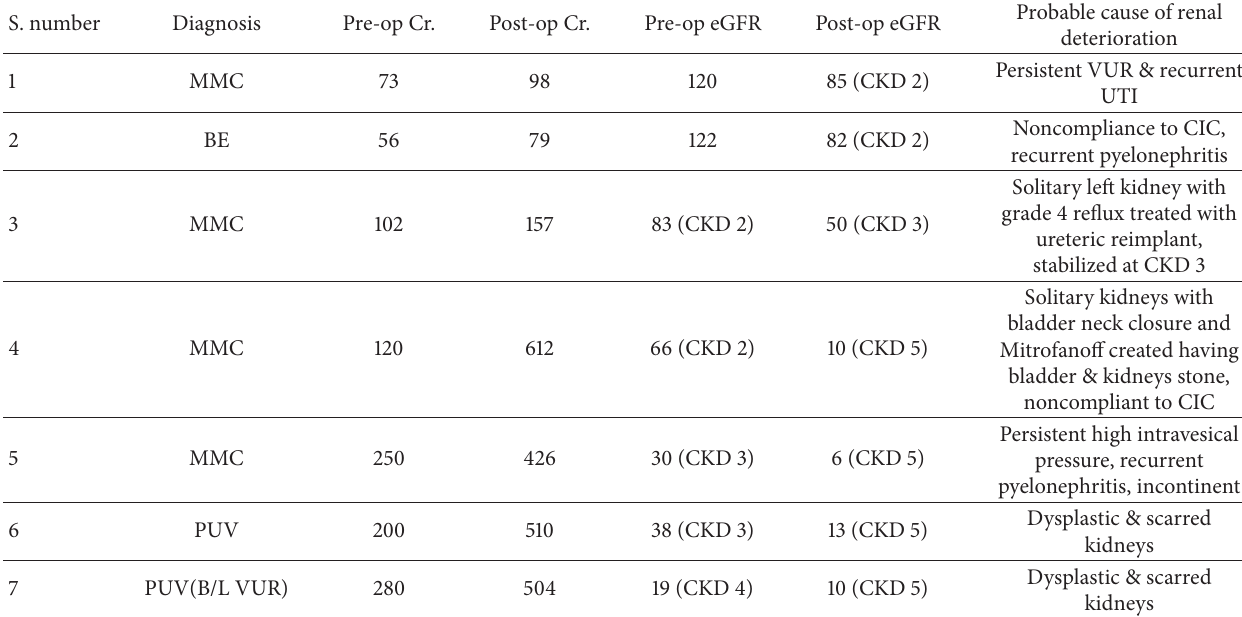
Table 4: Factors predicting renal